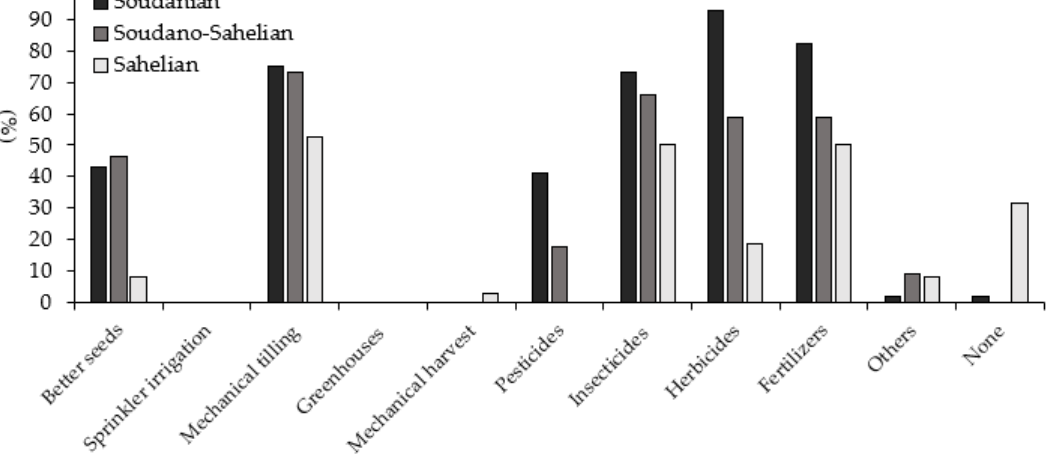
Figure 7. Use of plant growth regulators and agriculture mechanization methods in the different